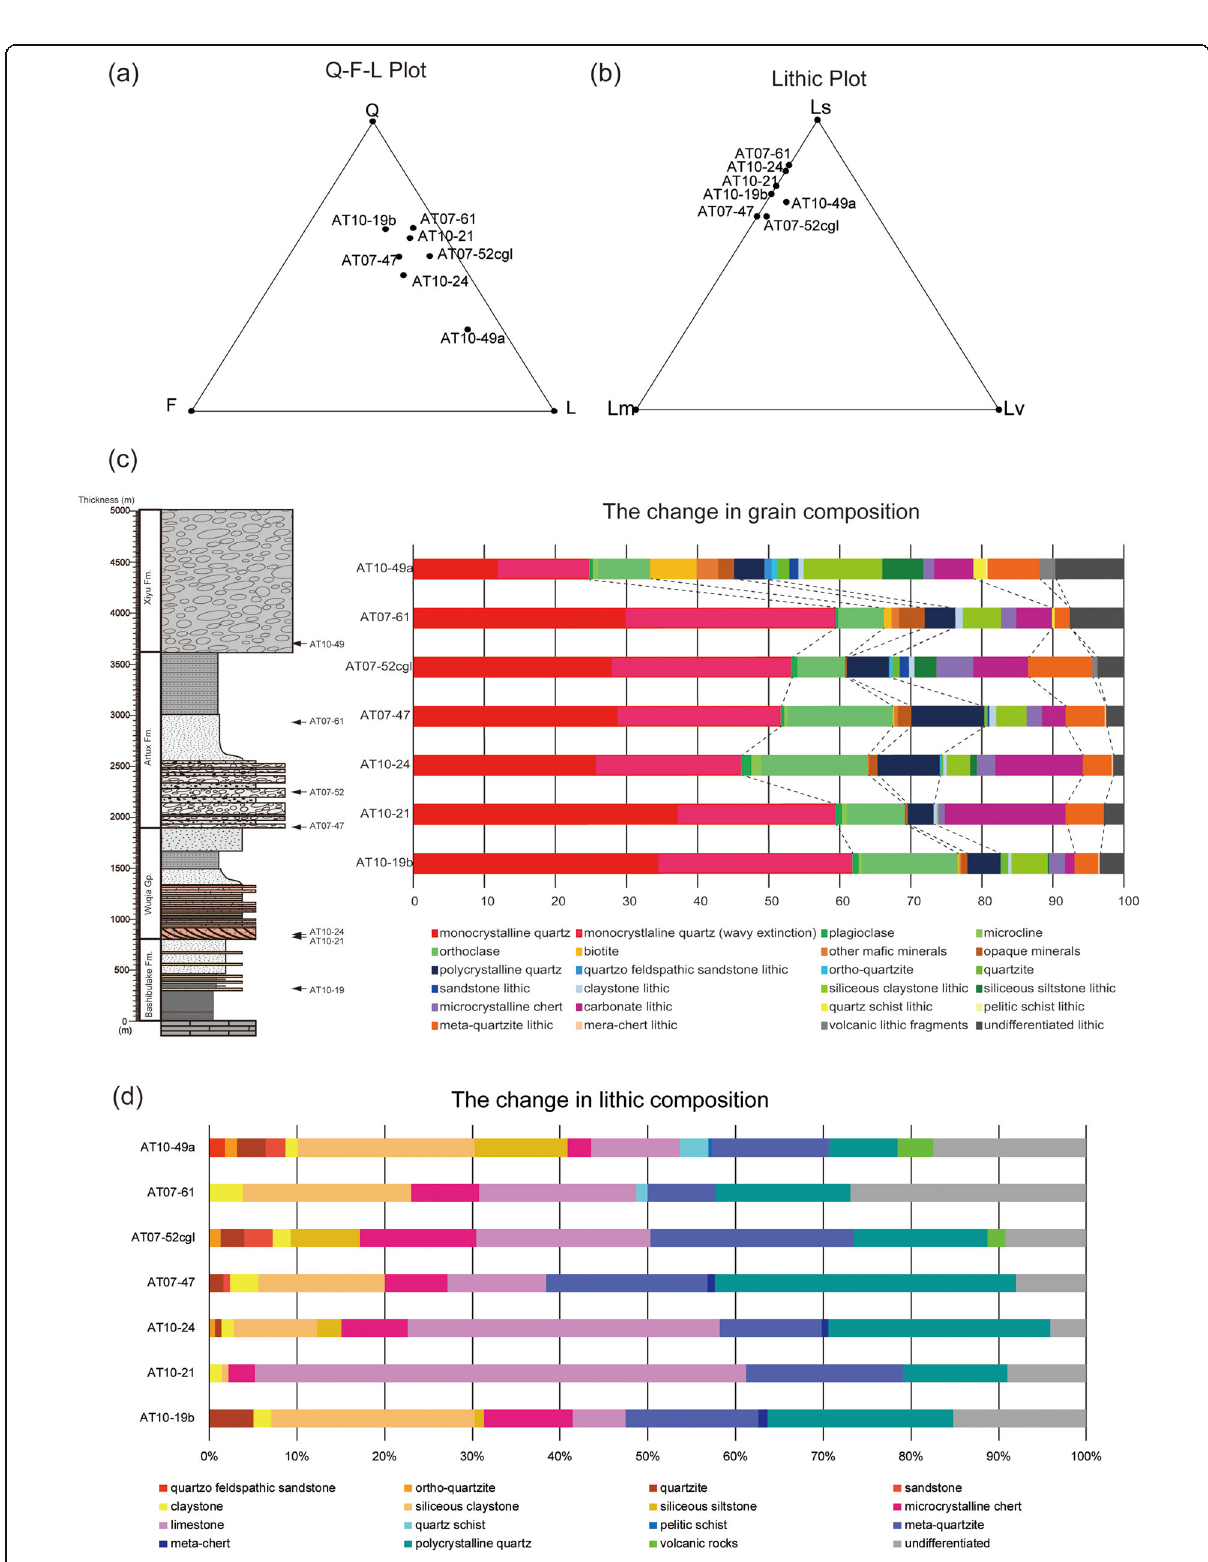
Fig. 7 Changes in grain composition. a Quartz-feldspar-lithic plot. b Lithic plot showing the ratio of sedimentary rocks, volcanic rocks, and metamorphic rocks. c Changes in grain compositions of fluvial sandstone in the Aertashi section. d Changes in lithic fragments in the Aertashi